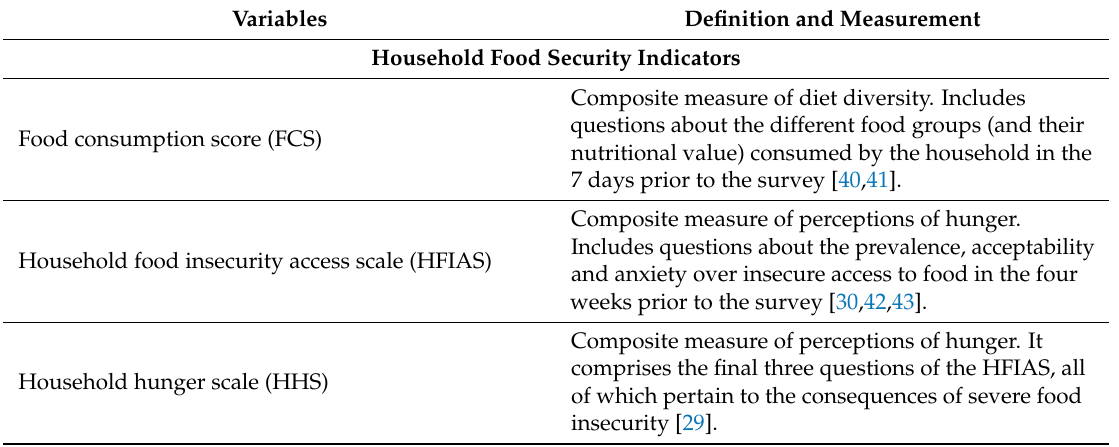
Table 1. Analytical variables and their